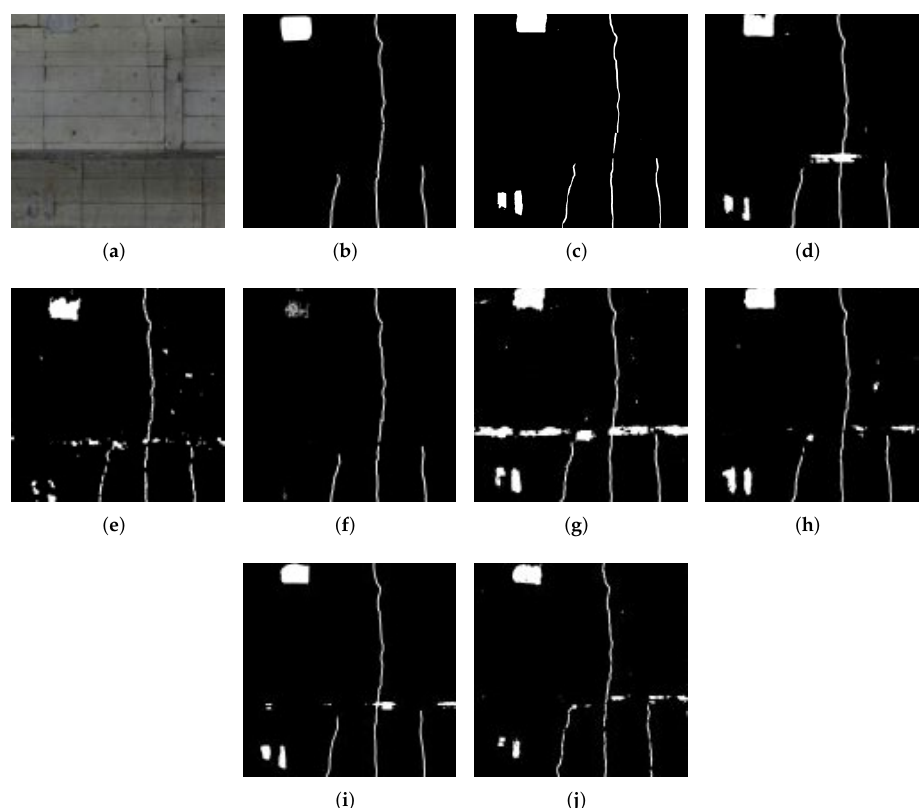
Figure 9. Example of the results of over-fitting parts. ( a ) Origin image. ( b ) Ground truth. ( c ) PM. ( d ) CM1. ( e ) CM2. ( f ) CM3. ( g ) CM4. ( h ) CM5. ( i ) CM6. ( j )